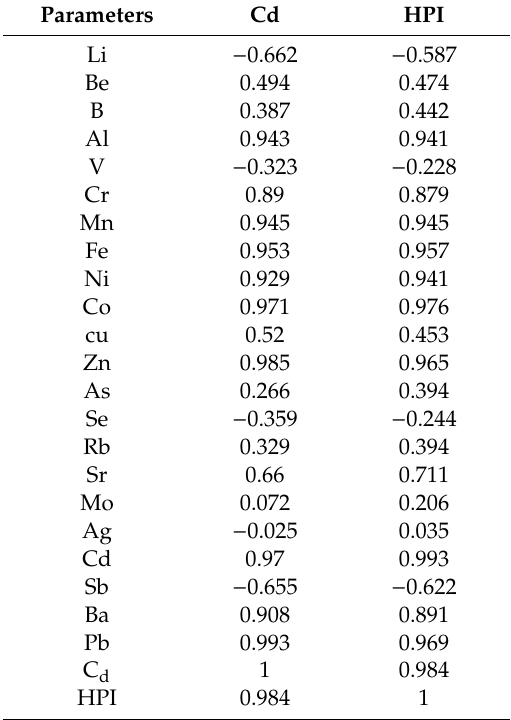
Table 7. Correlation coe ffi cients for metal concentrations and indices